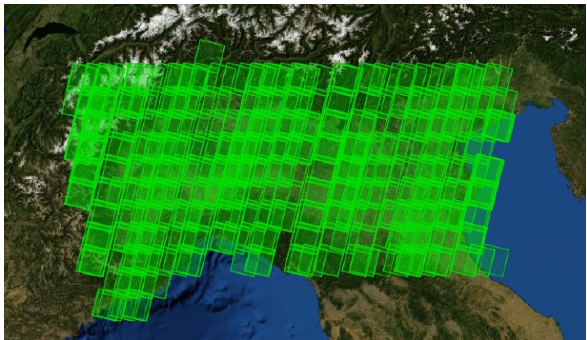
Figure 1: North Italy test area. The is covered by 414 Cartosat-1 stereo pairs, indicated by the green squares.